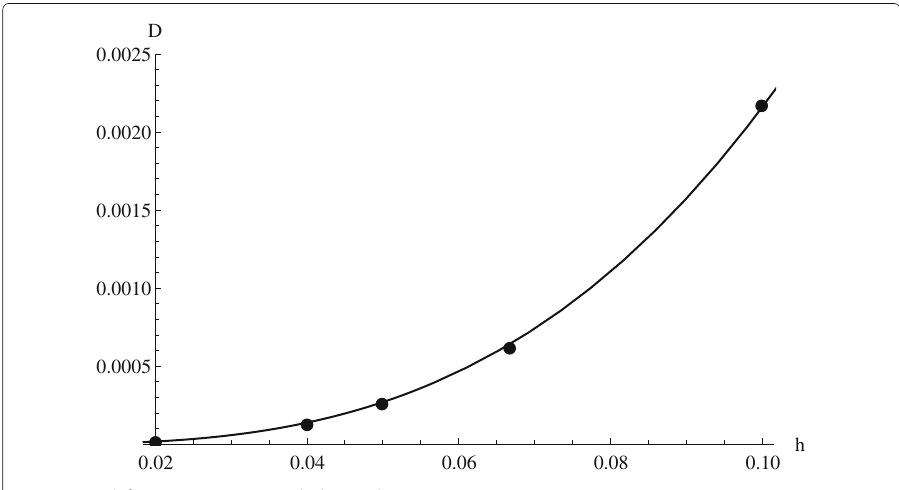
Fig. 2 D vs h for g ( x ) = sin2 π x with the S